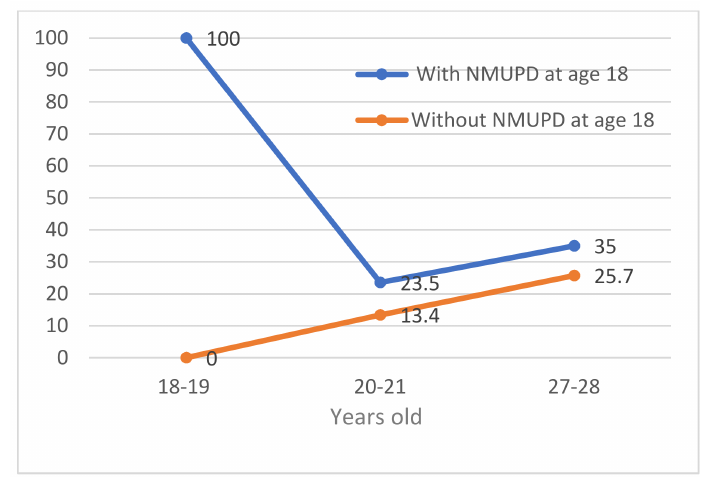
Figure 2. Trends in non-medical use of prescription drugs (NMUPD) (%) among men who already partook and who did not partake in this type of drug use at the beginning of the study.